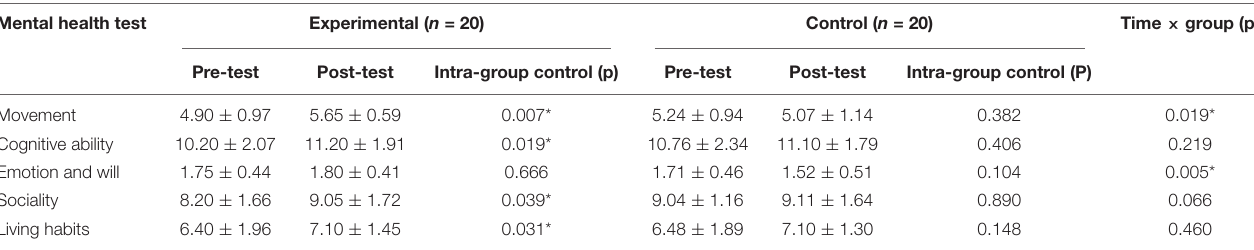
TABLE 6 | Mental health outcomes of experimental class and control class before and after experiment. Mental health